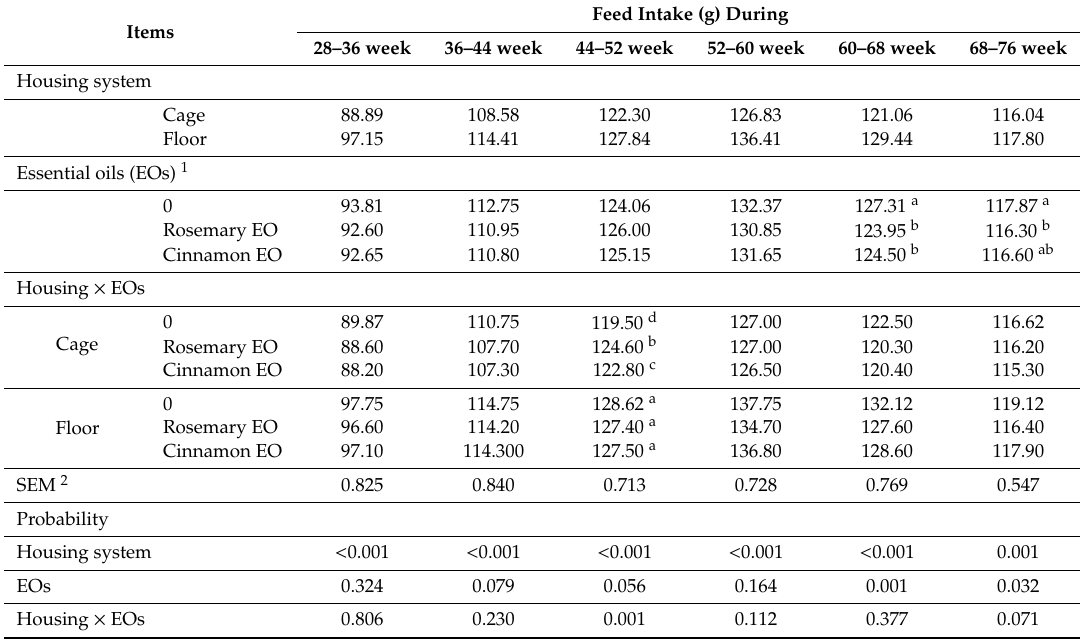
Table 5. Feed intake (g) of laying hens as a ff ected by di ff erent housing systems, essential oils and their interaction during the